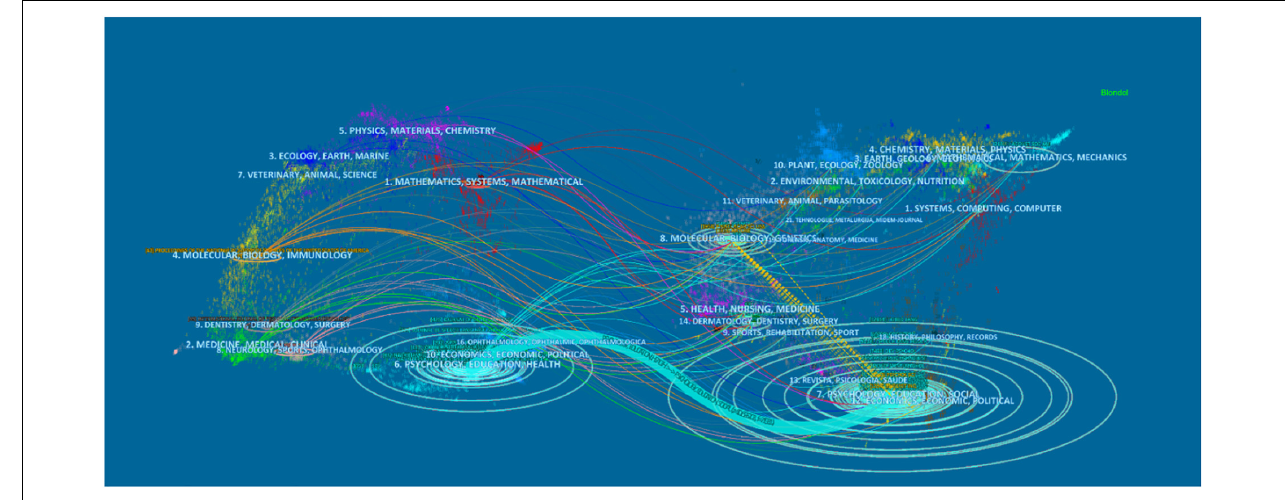
FIGURE 3 | A dual-map overlay of CL